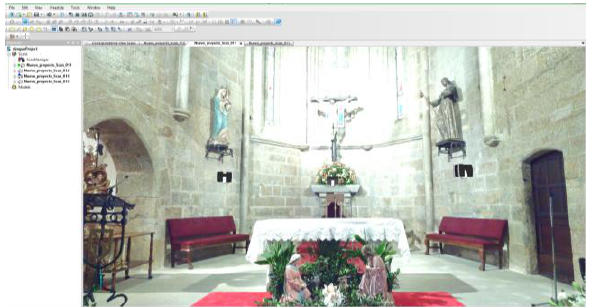
Figure 11. Scan Station 004 “3D View” in FARO SCENE.